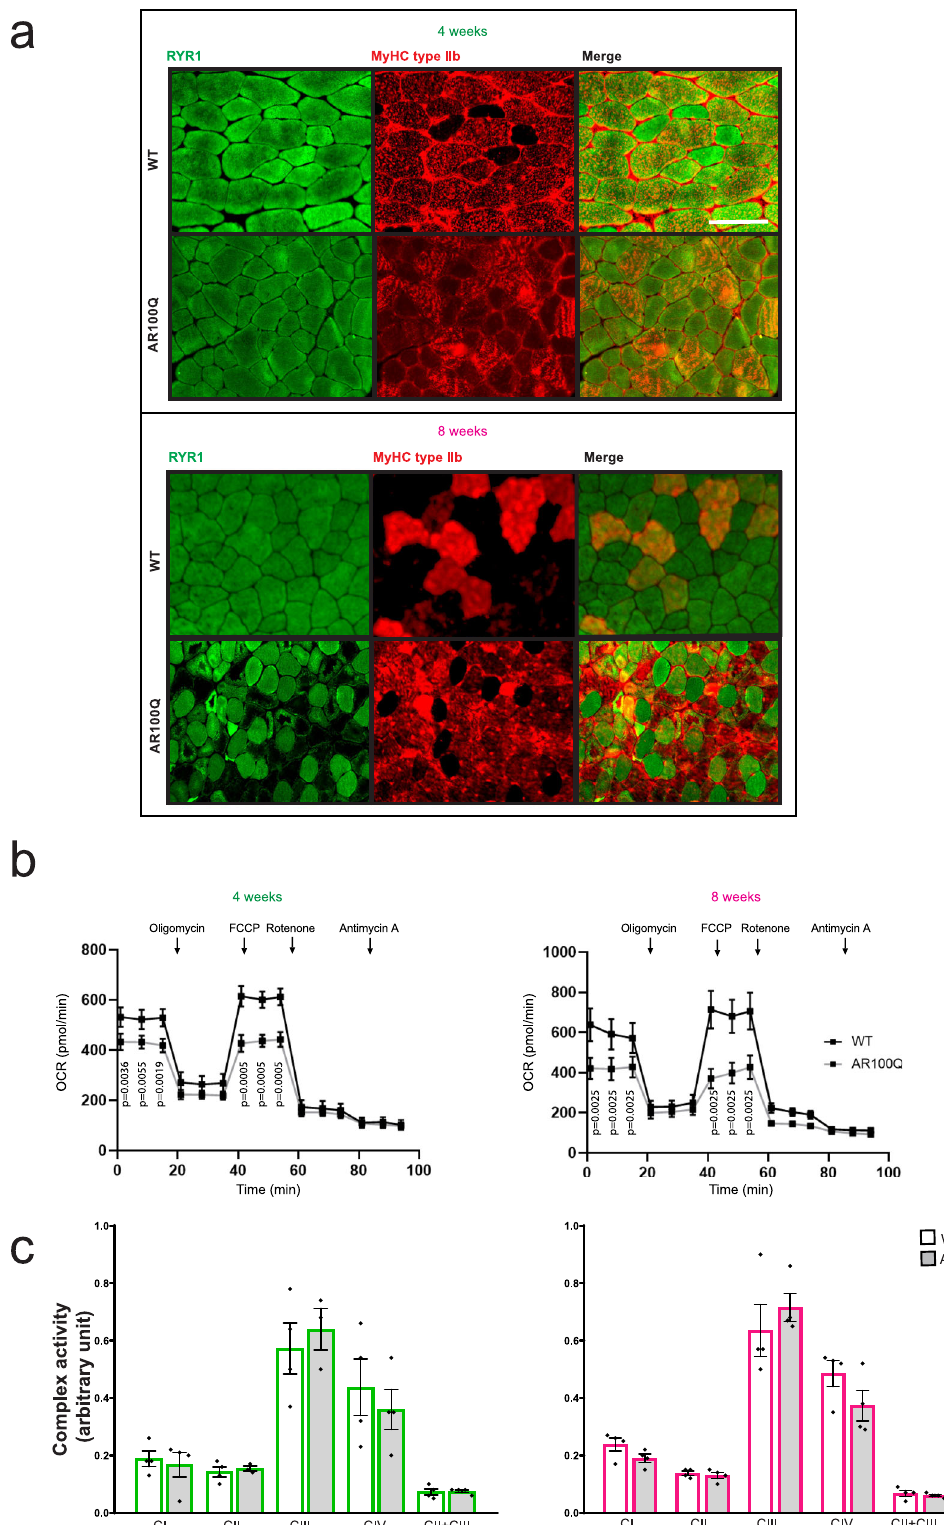
Fig. 4 | Earlydefects in mitochondrial respiration in the muscle ofSBMAmice. a Immuno fl uorescenceanalysisofRYR1(green)andMyHCtypeIIb(red)expression in the quadriceps of WT and AR100Q mice ( n =3 mice/genotype/age). Repre- sentativeimagesareshown.Bar,40 μ m. b AnalysisoftheOCRinFDB-isolated fi bers from 4- and 8-week-old WT and AR100Q mice ( n =4 mice/genotype/age). Oligo- mycin2 µ M, carbonylcyanide-p-tri fl uoromethoxyphenylhydrazone (FCCP) 0.6 µ M,